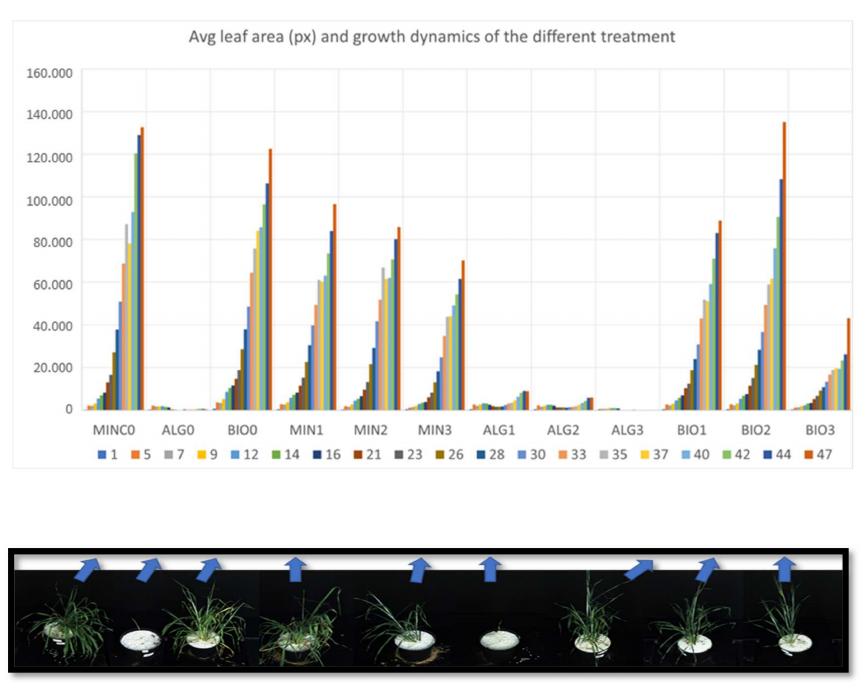
Figure 5. Average leaf area (pixels, px) and growth dynamics of Rehan under three fertilizers and four salinity levels analyzed by ScreenHouse system [30] (MIN: mineral fertilization, BIO: biochar with mineral fertilization, AlG: dried algae biomass powder from freshwater (0, 1, 2, 3: 0, 4, 8, 16 mS/cm EC, respectively). x -axis: measurement day during the growth